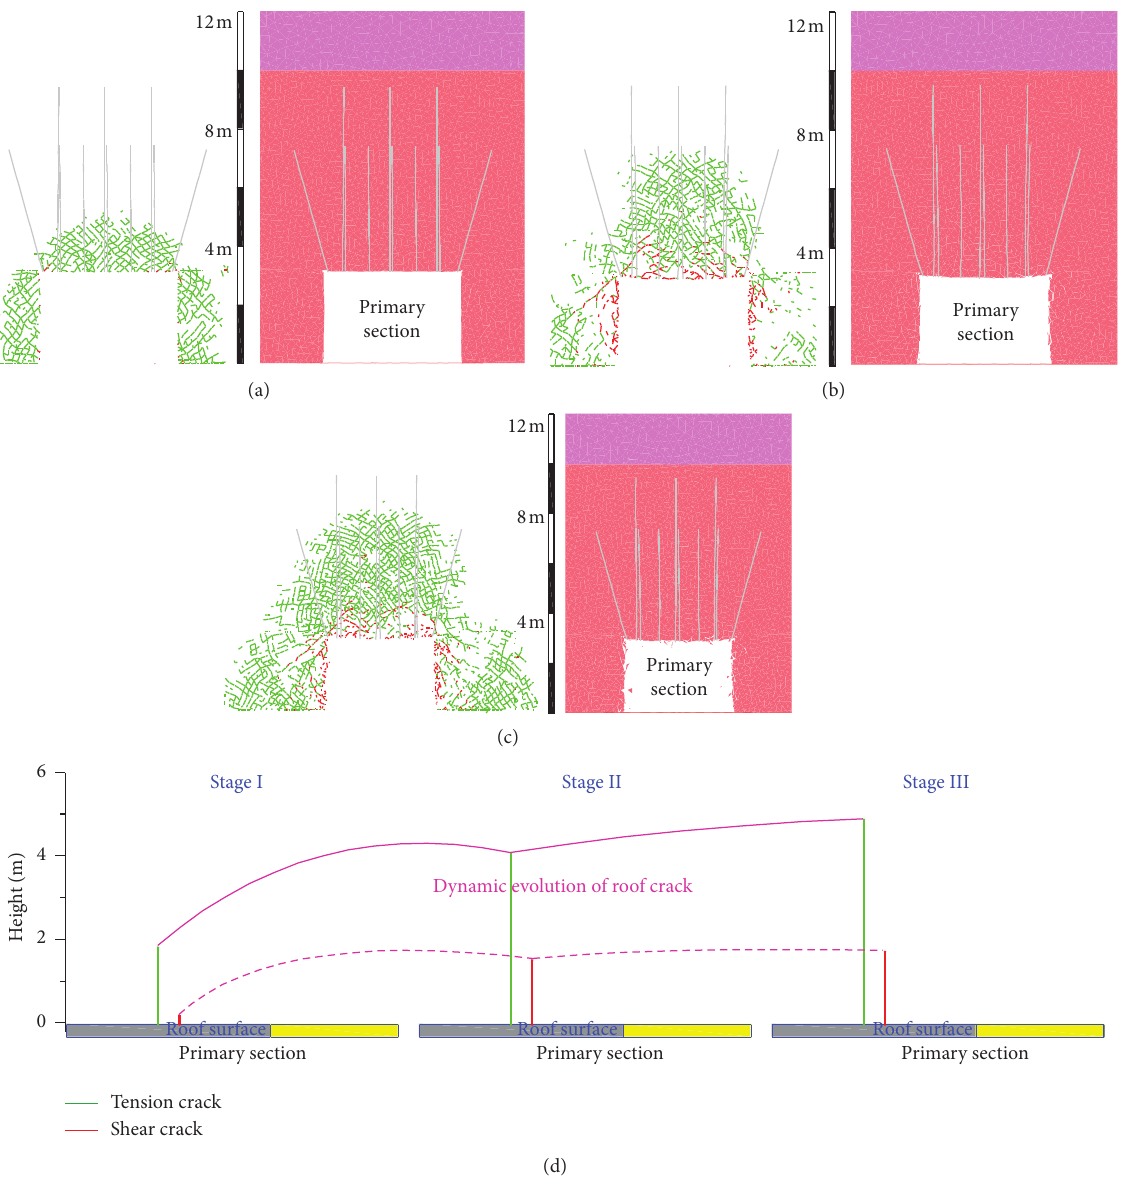
Figure 10: Crack development process and roof failure mode after primary excavation section supporting: (a) Stage I; (b) Stage II; (c) Stage III; (d) dynamic evolution of roof crack after primary excavation (green cracks represent tensile cracks, and the red cracks represent shear